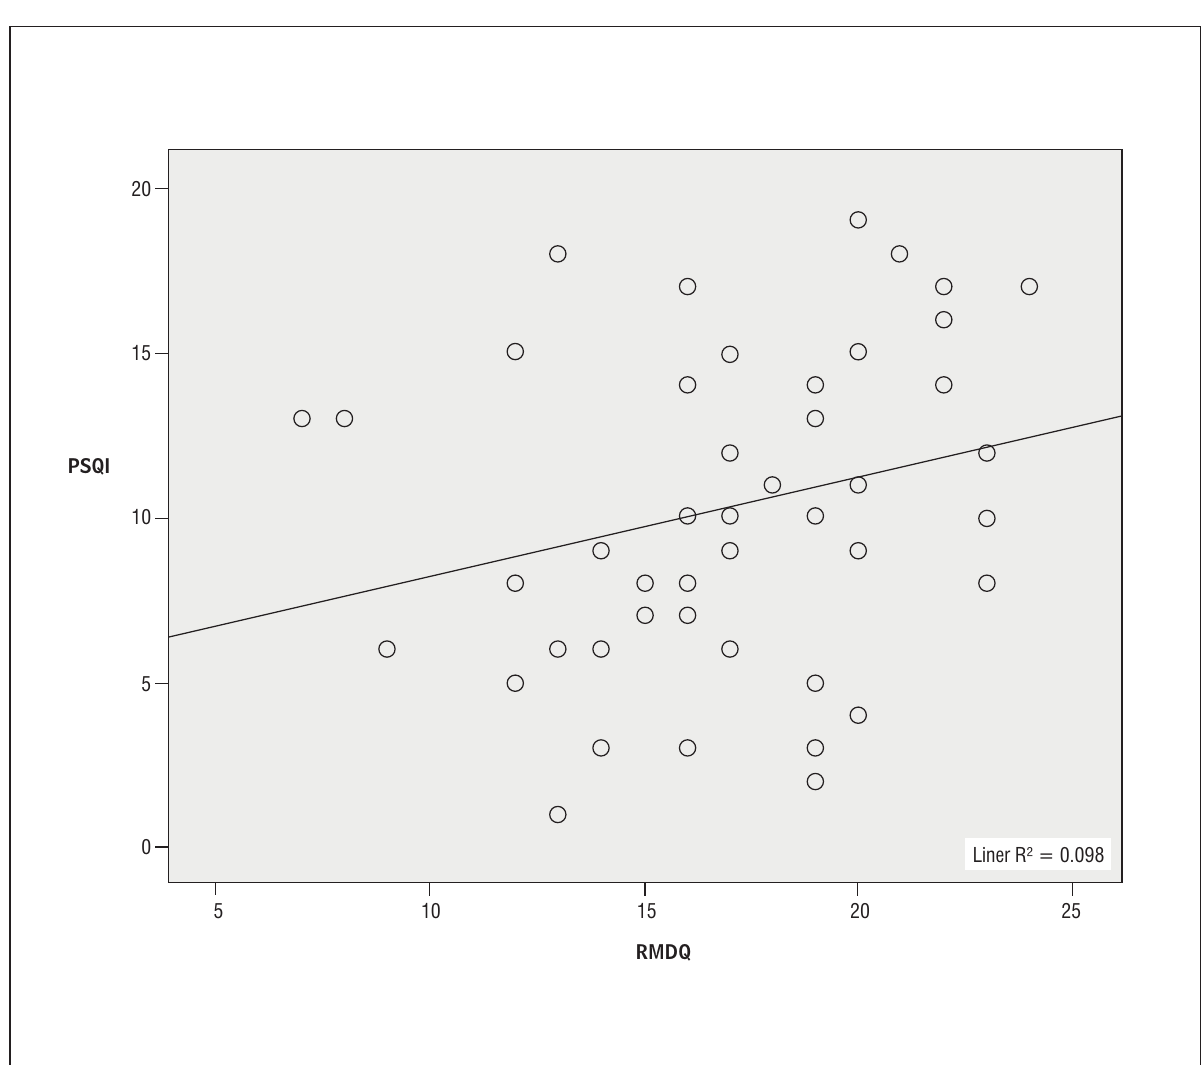
Figure 1 - Association between scores obtained in the Pittsburg Sleep Quality Index (PSQI) and in the Roland-Morris Disability Questionnaire